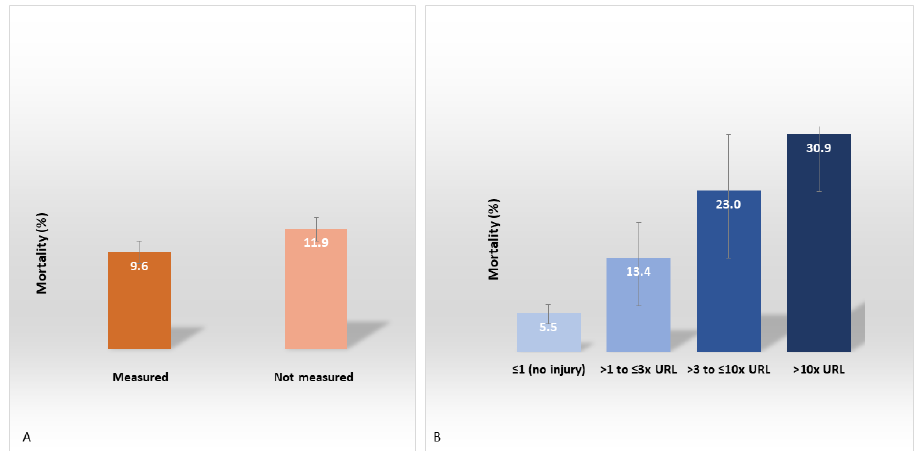
Figure 2. In-hospital mortality among patients with COVID-19 according to ( A ) troponin measure- ment ( n = 3246) and ( B ) troponin levels ( n = 1476) in the first week of hospitalization.